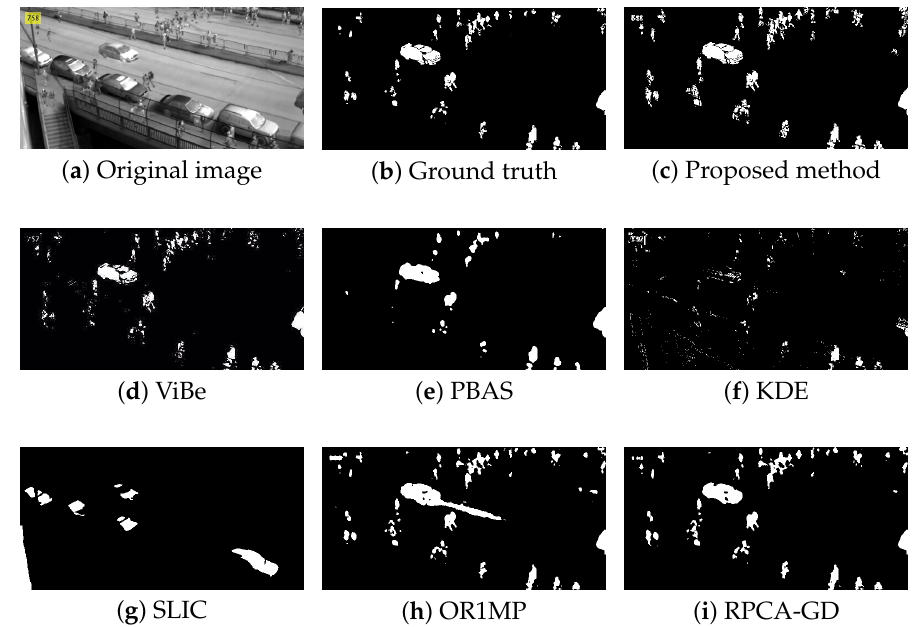
Figure 5. The detection results of the 758th frame in Seq. 2.